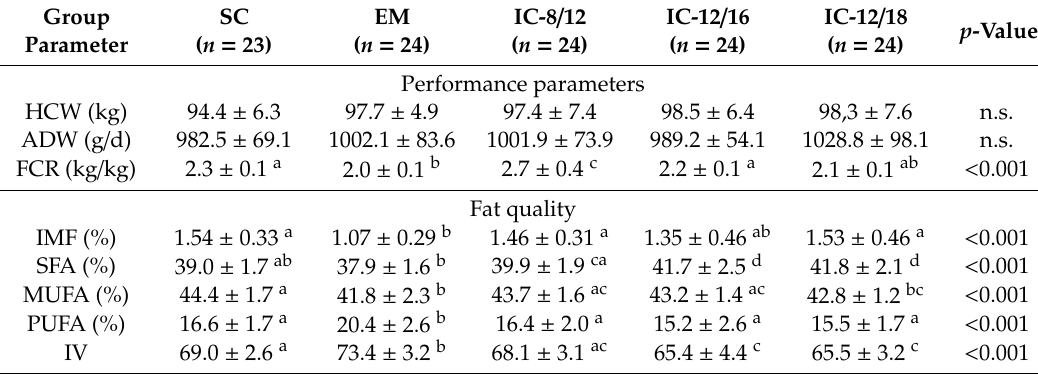
Values with di ff ering subscripts within a line di ff er significantly ( p < 0.05). nd: not determined; IMF: % Intramuscular fat; SFA: % Saturated fatty acids of all fatty acids (100%); MUFA: % Monounsaturated fatty acids of all fatty acids (100%); PUFA: % Polyunsaturated fatty acids of all fatty acids (100%); IV: iodine value; surgical castrates (SC); entire males (EM); immunocastrated boars in 8th and 12th wk (week of live) (IC8 / 12); 12th and 16th wk (IC12 / 16); 12th